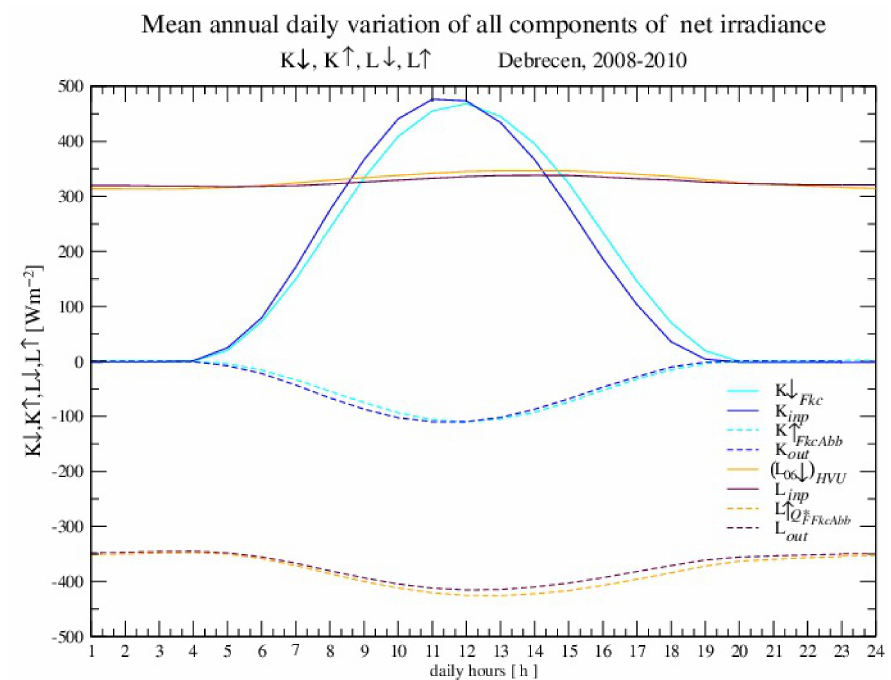
Figure 9. Mean annual daily variations of all four components of the radiation balance. The com- ponents are measured and calculated from routine meteorological measurements and